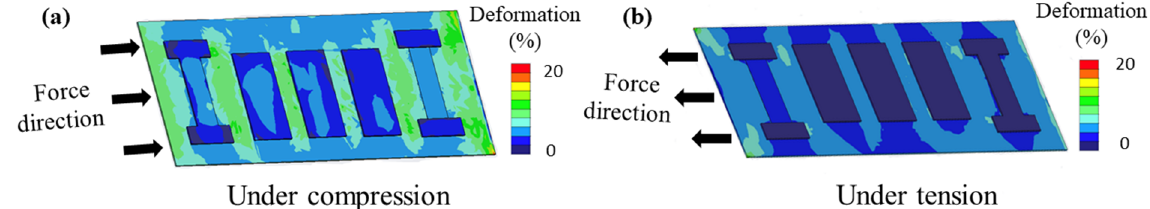
Figure 2. Finite element analysis of flexible biosensor. ( a ) Compression state. ( b ) Tensile state.